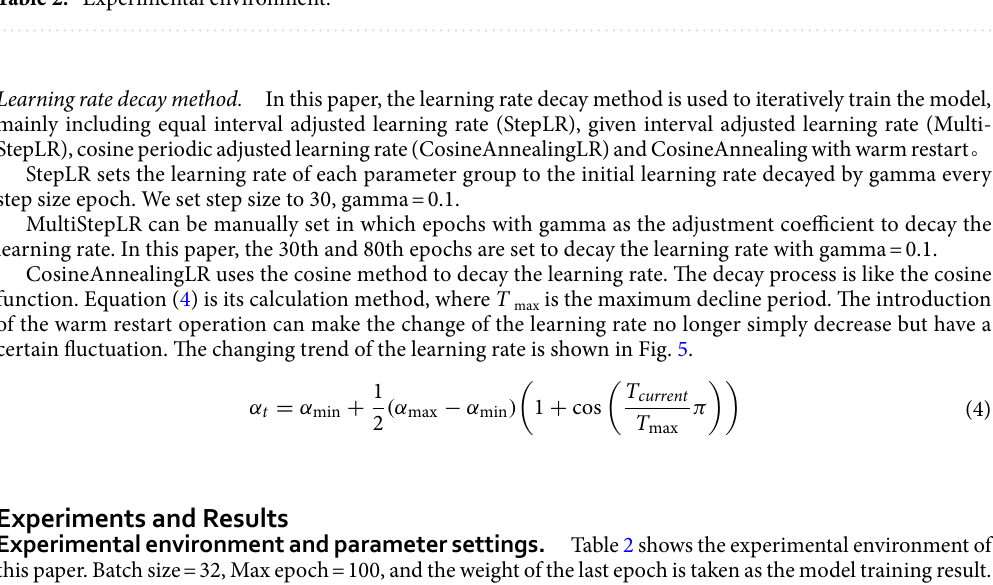
Table 2. Experimental